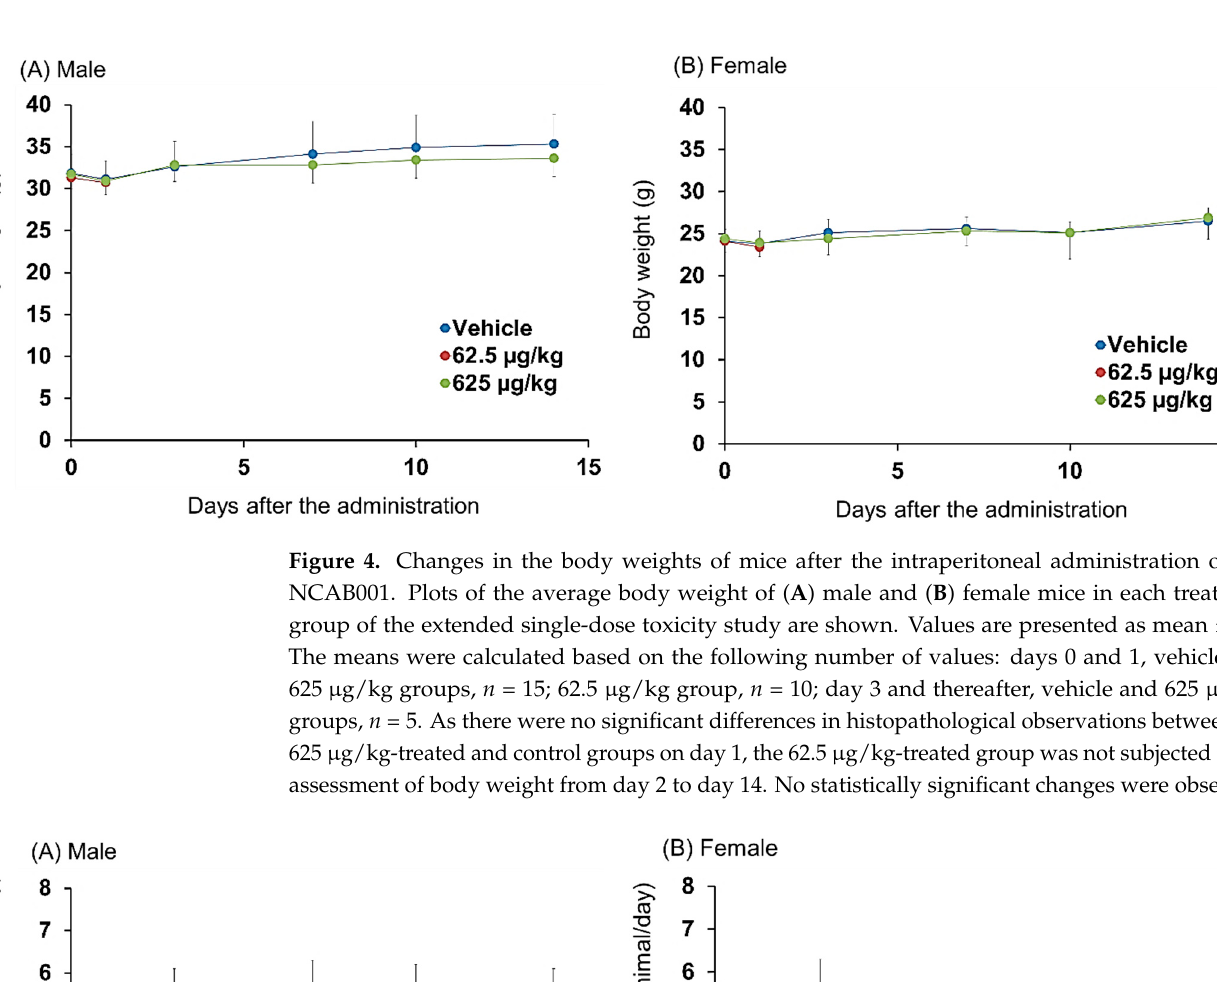
8 of 15 Figure 3. Relative binding potency of Cu-NCAB001 to recombinant human EGFR before and after the toxicity study was determined using the enzyme-linked immunosorbent assay (ELISA). Cetux- imab was used as the reference standard. No statistically significant changes were observed. 3.2. Single-Dose Extended Toxicity Study of Intraperitoneally Administered Cu-NCAB001 in